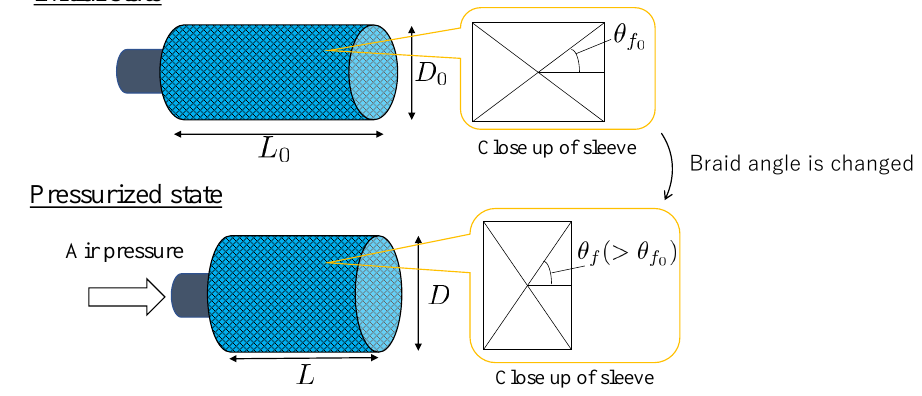
Figure 3. The structure of McKibben artificial